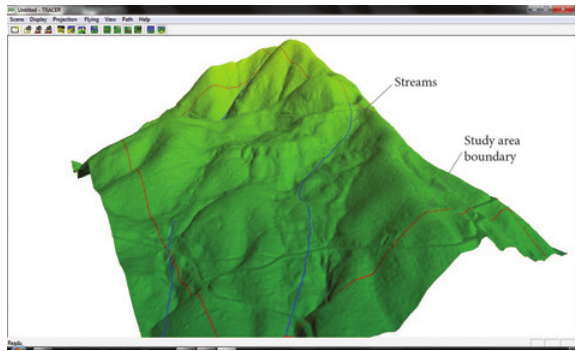
Fig. 3. 3D view of the study topography within TRACER’s